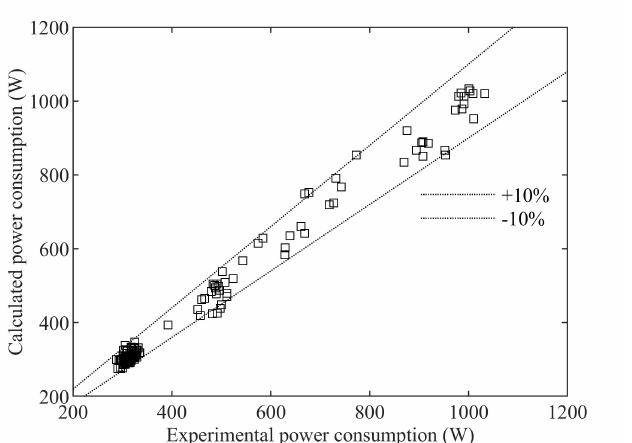
Figure 6. Comparison between experimental and predicted instant overall power